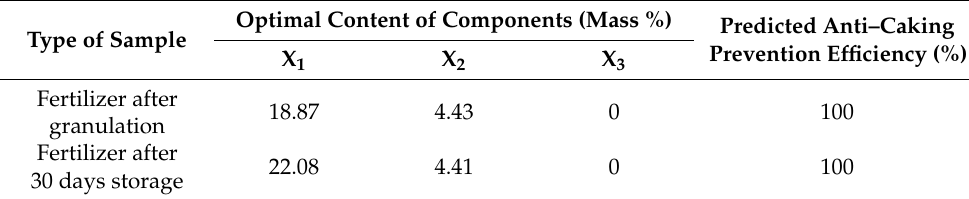
Table 5. Optimal compositions of anti-caking agents and predicted results of anti-caking prevention. Type of Sample